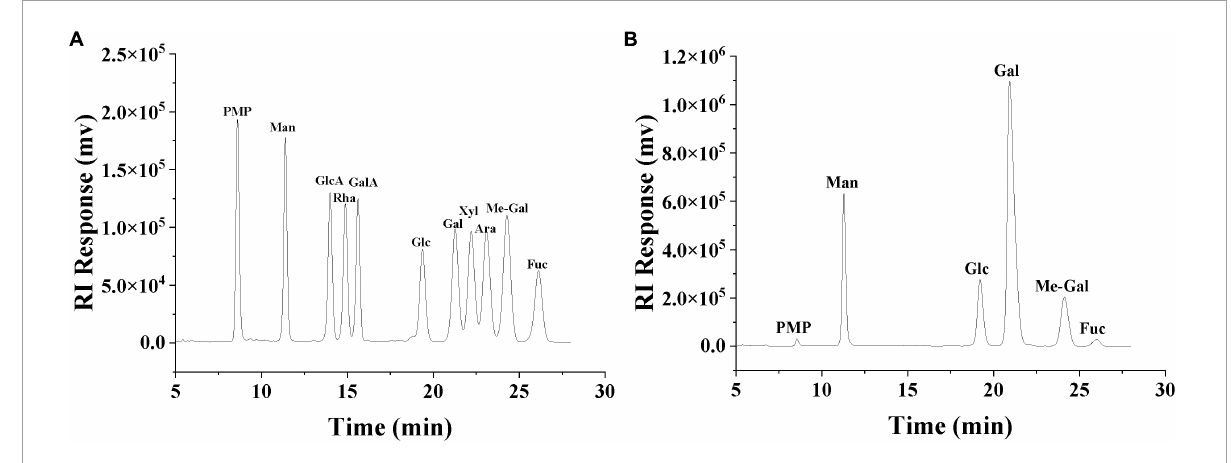
FIGURE4 HPLC chromatogram of monosaccharide standards (A) . HPLC chromatogram of the monosaccharide composition of SRF-3 (B)